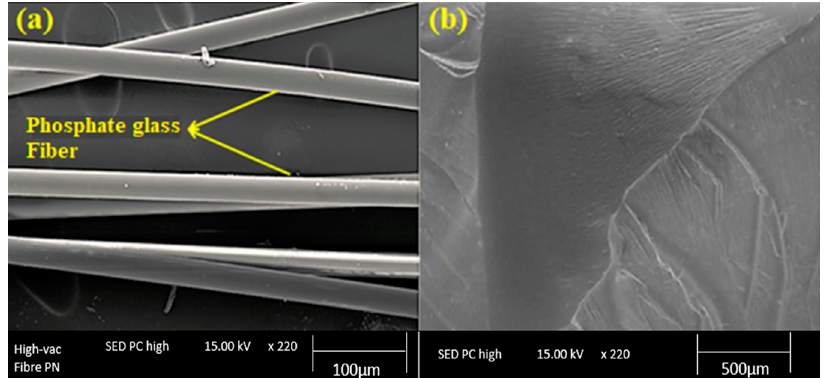
Figure 6. SEM images of the reinforcement ( a ) and the polyester matrix ( b ).